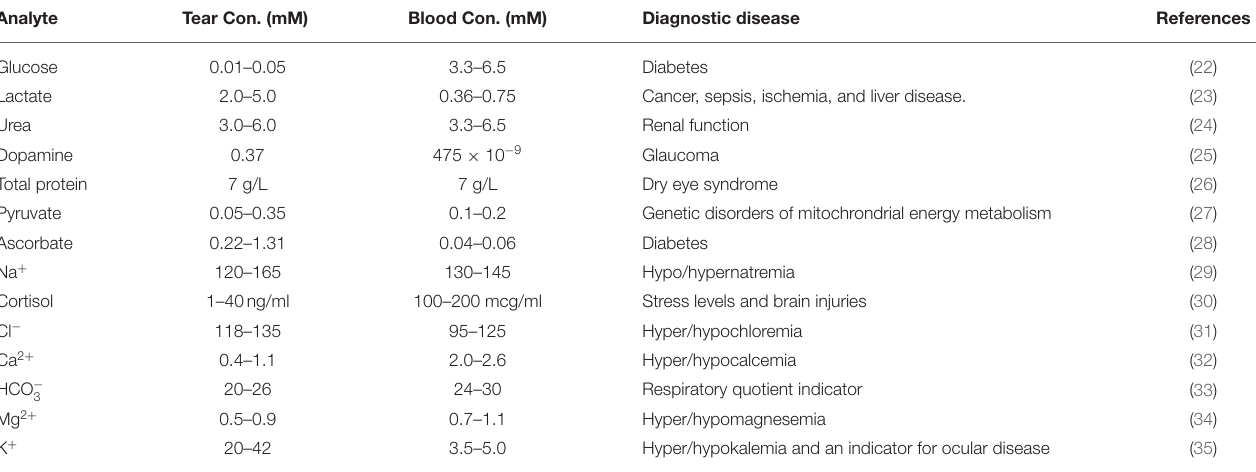
TABLE 2 | Comparison between tear and blood biomarkers, and their applications.